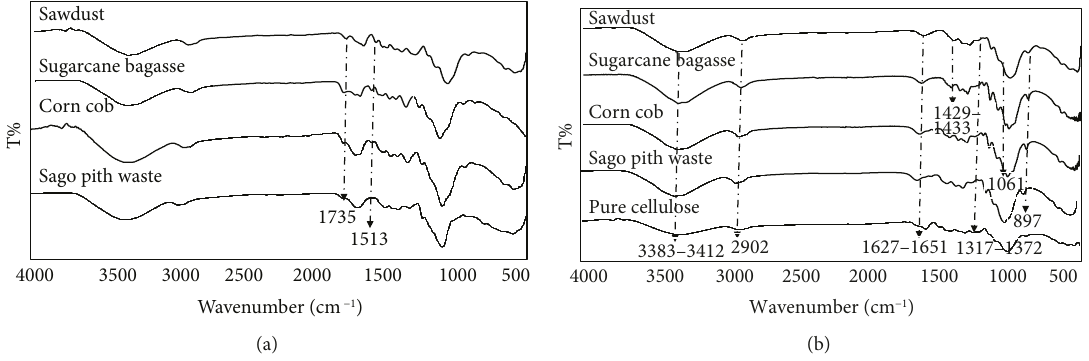
Figure 1: FTIR spectra of various lignocellulosic biomass waste samples (a) before and (b) after alkaline